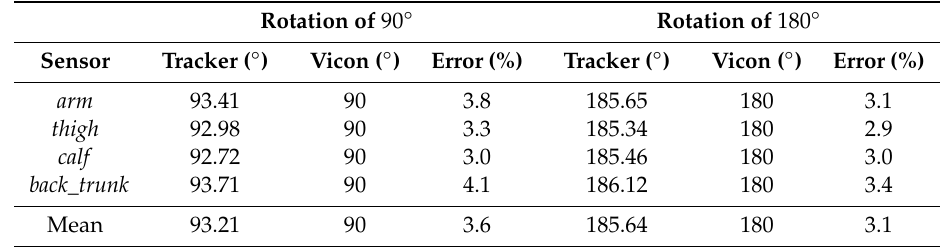
Table 4. Validation results of the trackers in the 90 ◦ and 180 ◦ rotation tests. The results showed that each tracker has a static error rate < 4%.